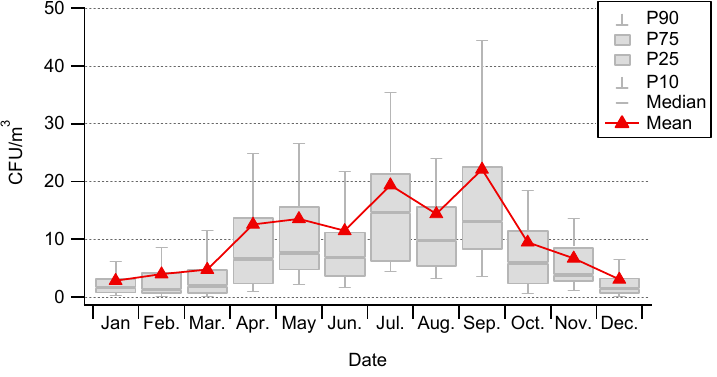
Figure 5. Seasonality of airborne cultivable bacteria at Saclay from 10 January 2018 to 31 May 2020.